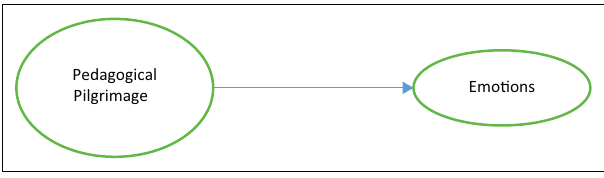
FIGURE 3: A pedagogical